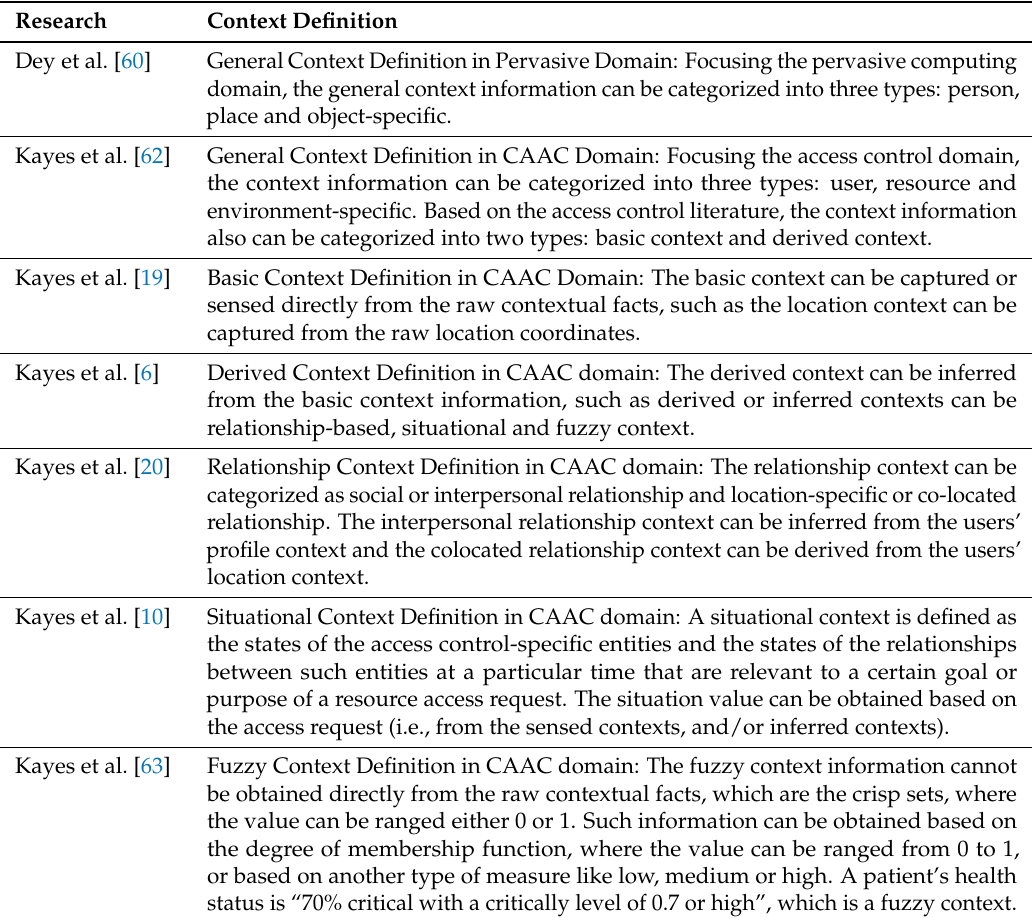
Table 3. Definition of context